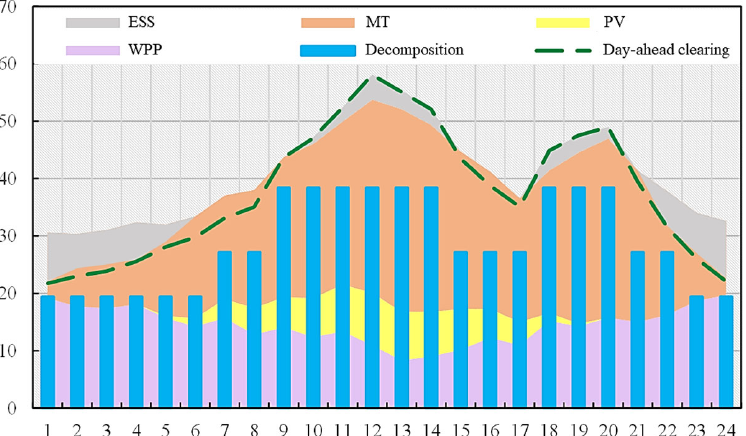
Figure 9. Power output of VPP under insufficient output of renewable energy (MWh).